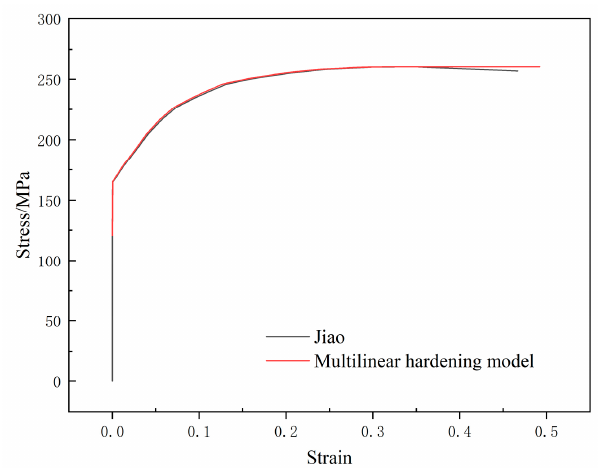
Figure 4. Tensile test model.